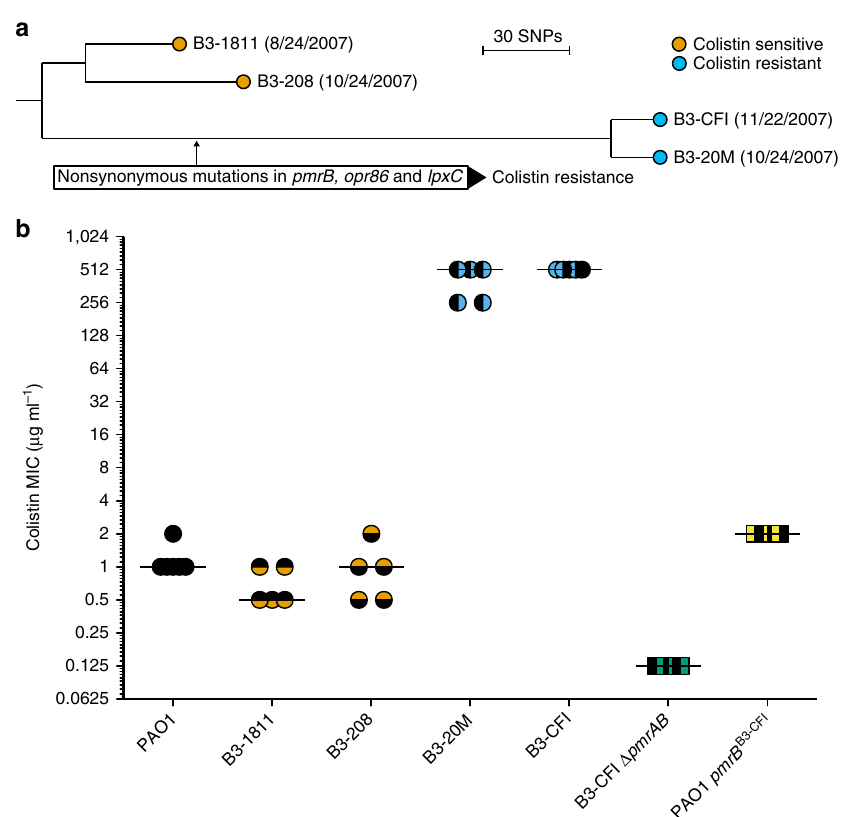
Figure 1 | High-level colistin resistance in clinical isolates is multi-factorial. ( a ) Maximum-parsimonious phylogenetic tree representing the evolutionary relationship of P. aeruginosa isolates from patient B3. The tree shows the relationship between isolates based on 334 SNPs identified from genome sequencing with an equal number of mutational events (that is, perfect consistency). The P. aeruginosa reference isolate PAO1 sequence was used as outgroup to determine the root of the tree. Branch lengths are proportional to number of SNPs between isolates. Date of isolation is in parentheses after the strain designation. ( b ) MICs ( m gml (cid:2) 1 ) from microbroth dilution of P. aeruginosa PAO1 (PAO1), the B3 clinical isolates, B3-CFI pmrAB deletion (B3-CFI D pmrAB ) and P. aeruginosa PAO1 allelic replacement mutant with pmrB 634G 4 A, 742G 4 A allele from B3-CFI (PAO1 pmrB B3 (cid:2) CFI ). Horizontal lines represent median MIC values of three or five replicates. Data underlying the figure is also presented in Supplementary Tables 2 and